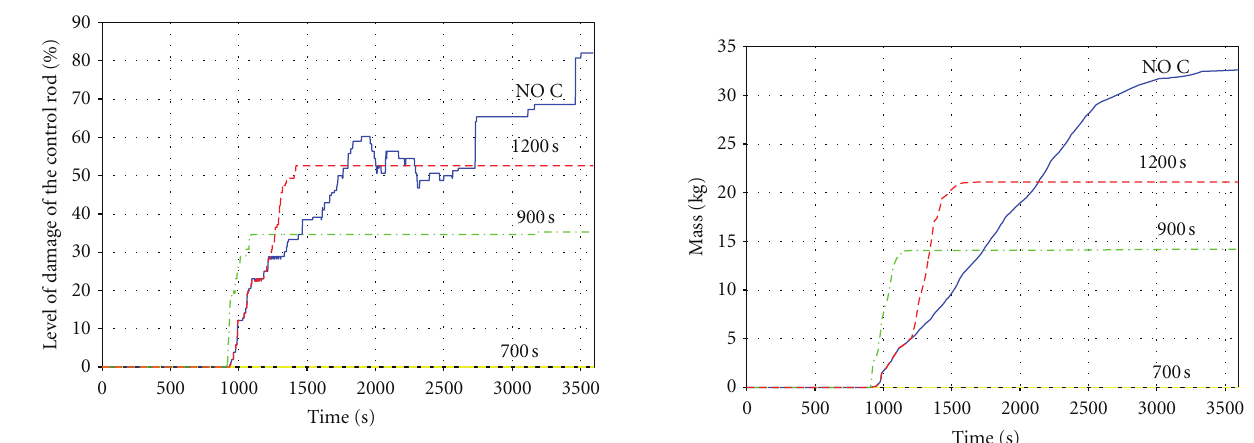
Figure 7: Level of damage of the control rod. HPCS injection to 700s, 900 s, and 1200 s; NO C indicates without HPCS injection.